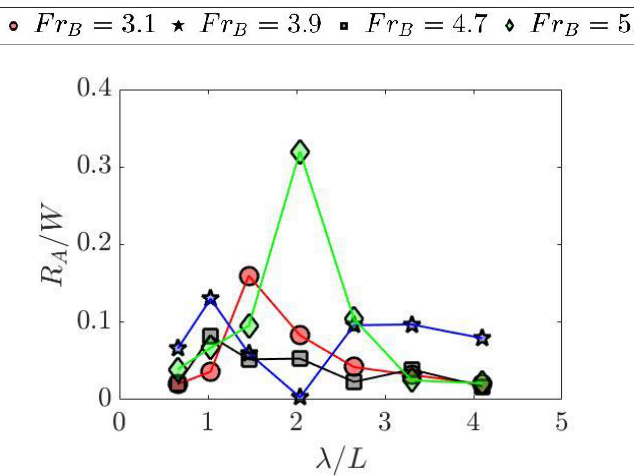
Figure 10. Resistance of Model B in waves.